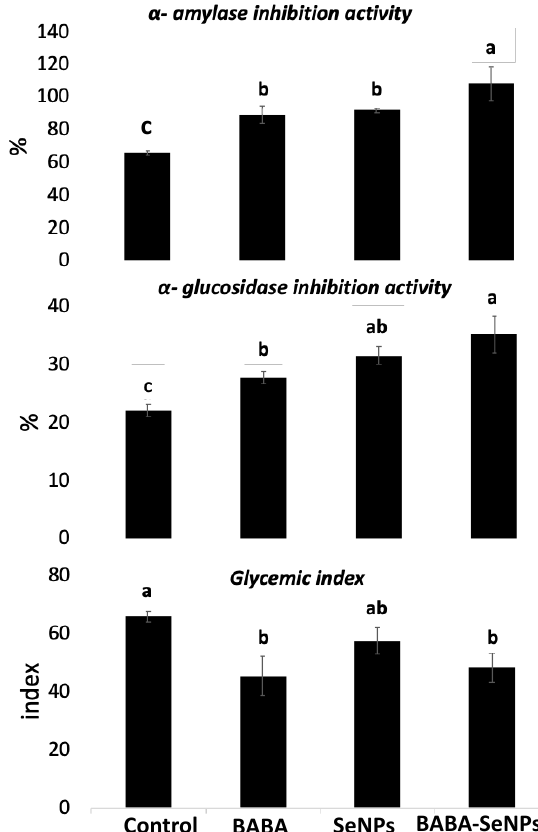
Figure 2. α -amylase and α -glucosidase inhibition activities, and the glycemic index (GI) of control and BABA- and/or SeNPs-treated M. interexta sprouts. Data are represented by the means of four replicates ± standard deviations. Different small letters (a–c) within a row indicate significant differences between control and BABA and/or SeNPs samples. One-way analysis of variance (ANOVA) was performed. Tukey’s test was used as the post hoc test for the separation of means ( p < 0.05).